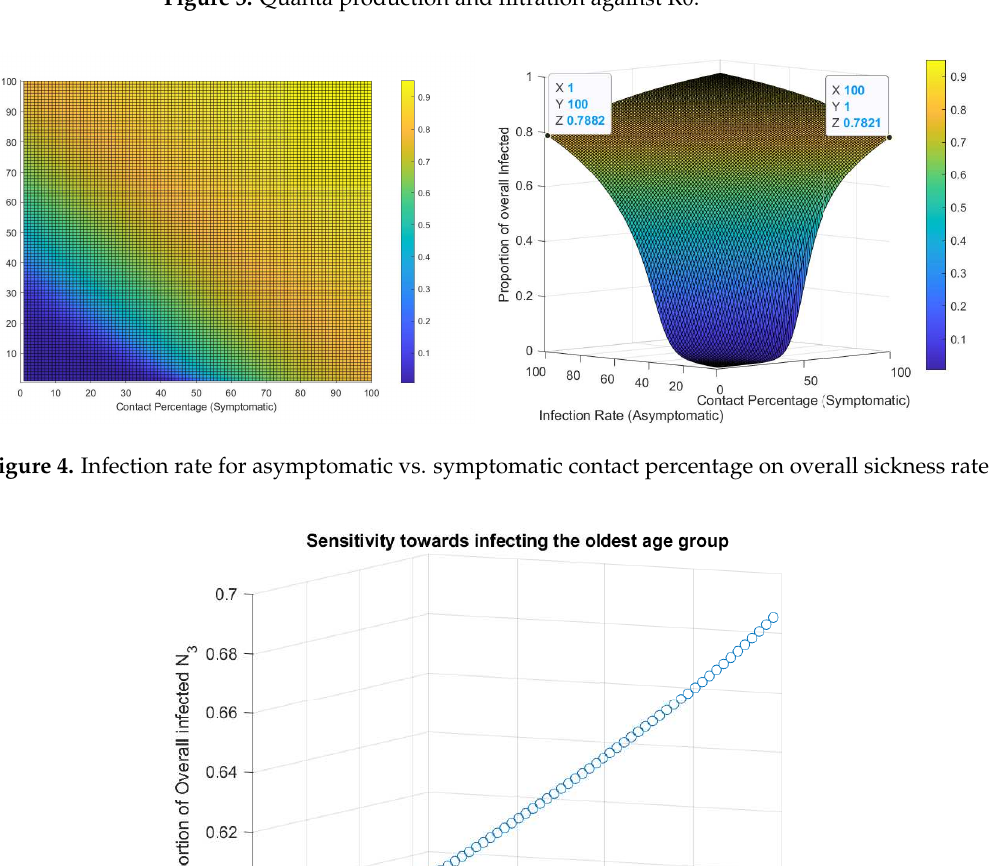
Figure 3. Quanta production and filtration against R0.